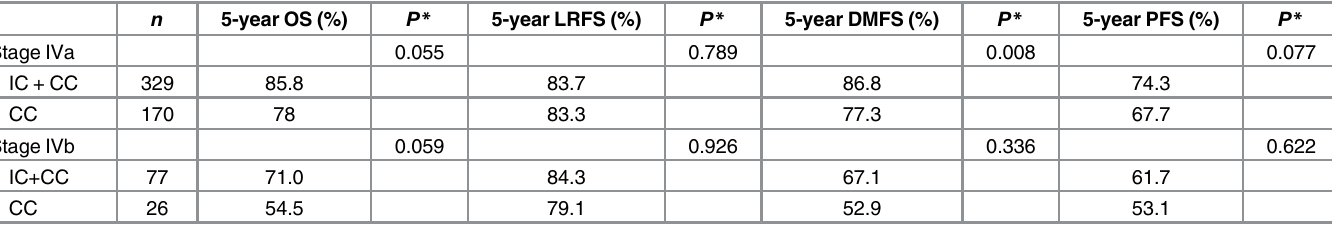
Table 5. Summary of subgroup analysis of the effect of induction chemotherapy in patients with stage IVa and IVb nasopharyngeal